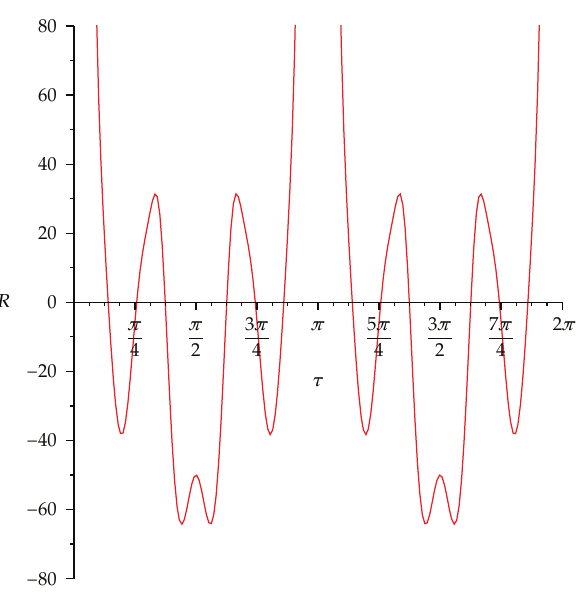
Figure 25: The evolution of the R with respect of the cosmic time τ for (cid:2) 5.5 (cid:3) .